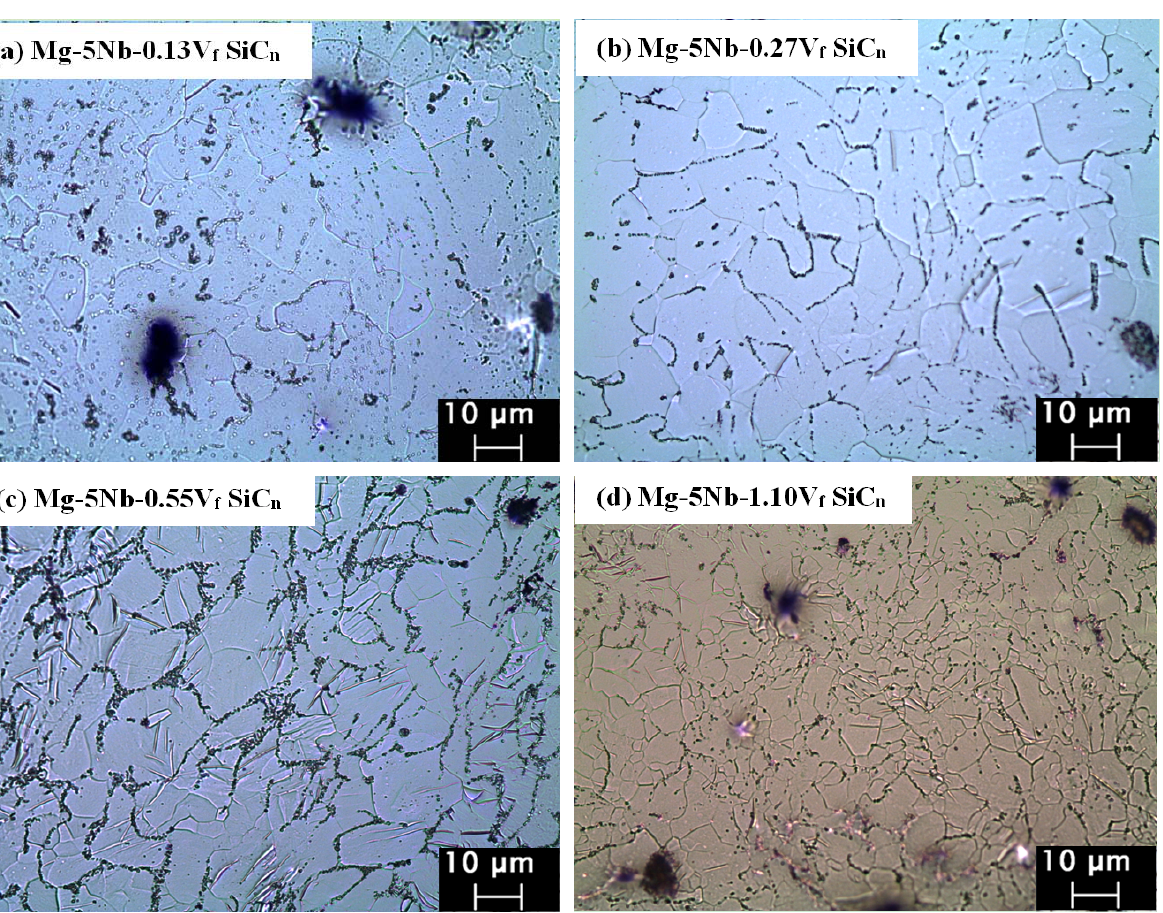
Figure 1. Optical micrographs of ( a ) Mg-5Nb-0.25SiC